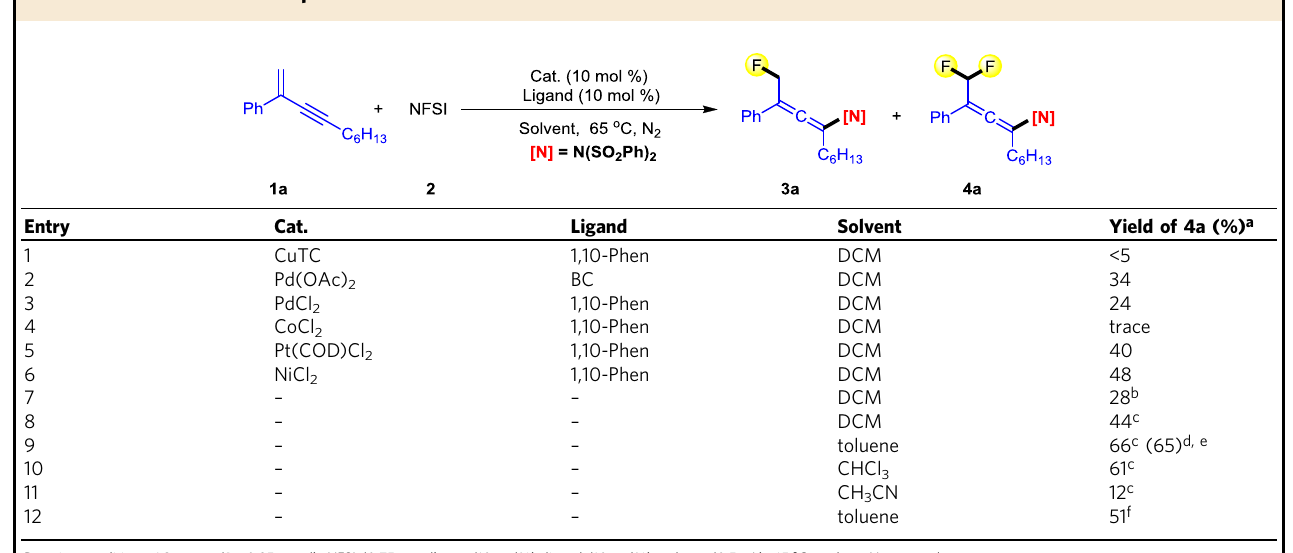
Table 1 Reaction condition